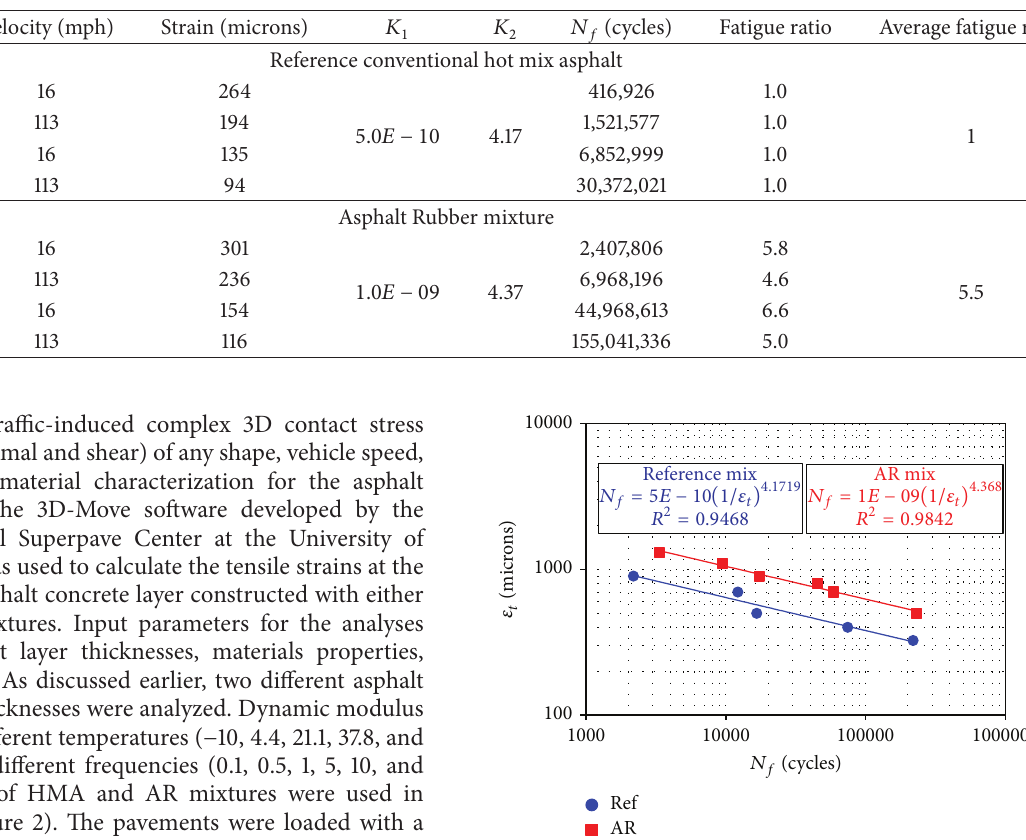
Table 2: Mechanistic fatigue analysis results.